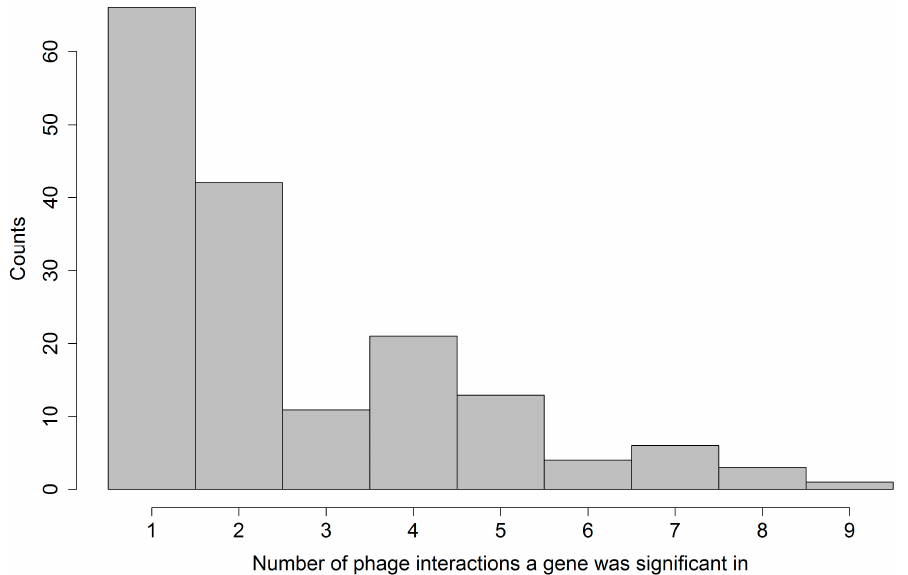
Figure 6. Histogram depicting the number of phage models where a given gene family was identified significant. Table 3. Predicted functions of the gene families found significant in interaction with eight or more phages. Gene Family ID Times